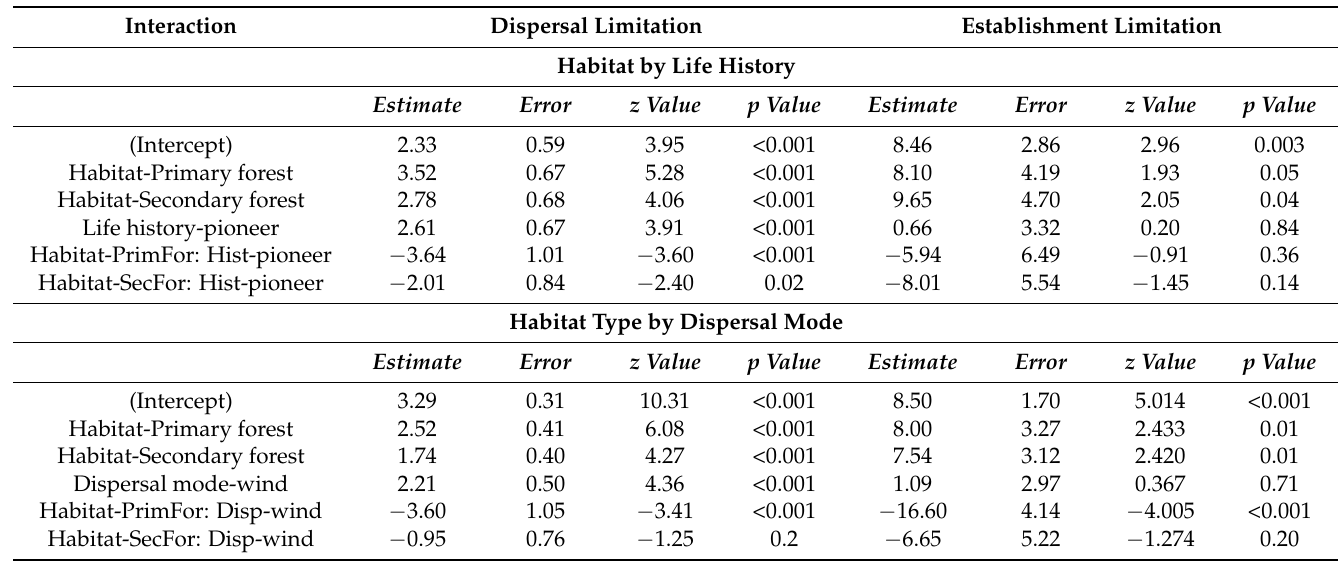
Table 3. Summary of results of the generalized linear models for each response variable analyzed (dispersal and establishment limitation) in the interaction of habitat (Primary Forest (PrimFor), Secondary Forest (SecFor) by life history (Hist) and habitat by dispersal mode